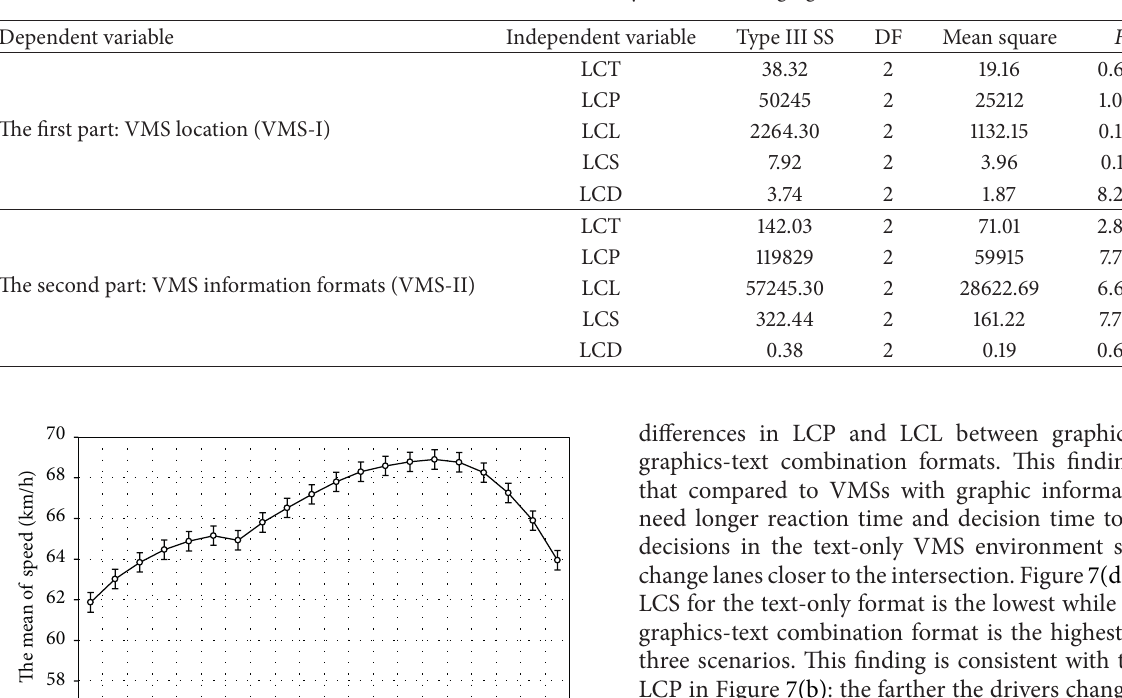
Table 5: MANOVA variance analysis of lane changing behavior.